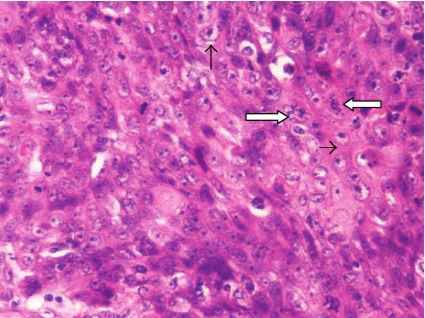
Figure 5: Pathology of the tumour. Thymic squamous cell carci- noma with eosinophilic cytoplasm (horizontal arrow) and vesicular nuclei with nucleoli (vertical arrow). Note atypical mitoses (thick arrows), IHC ×